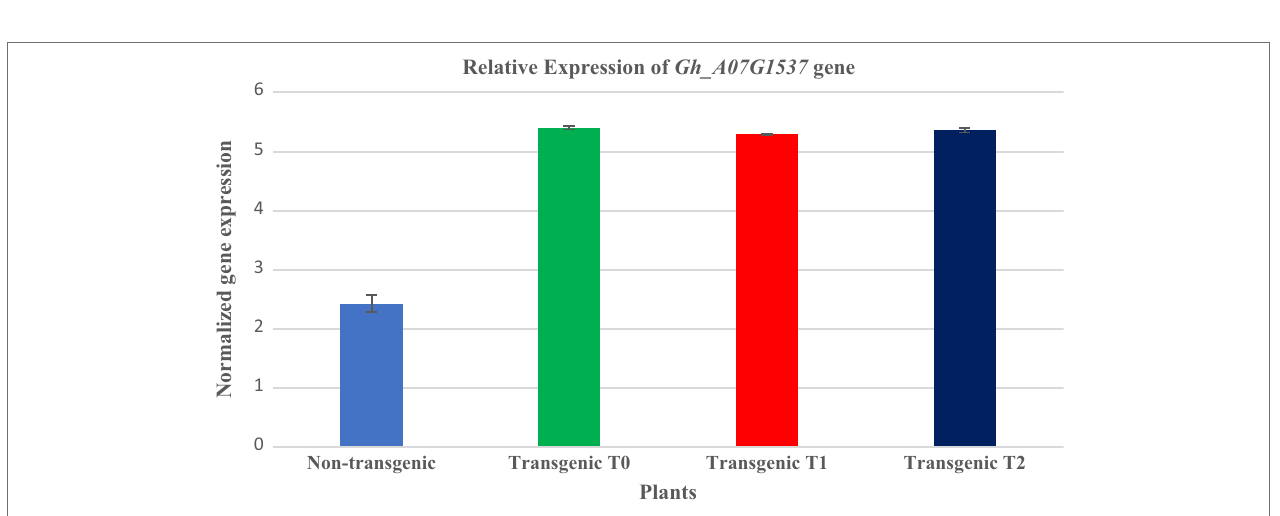
FIGURE 8 | Confirmation of transgene integration into the cotton genome by the Southern Blot Analysis. Lane M: 1 kb molecular weight marker; Lanes 1–3: transgenic cotton; Lane 4: non-transgenic.